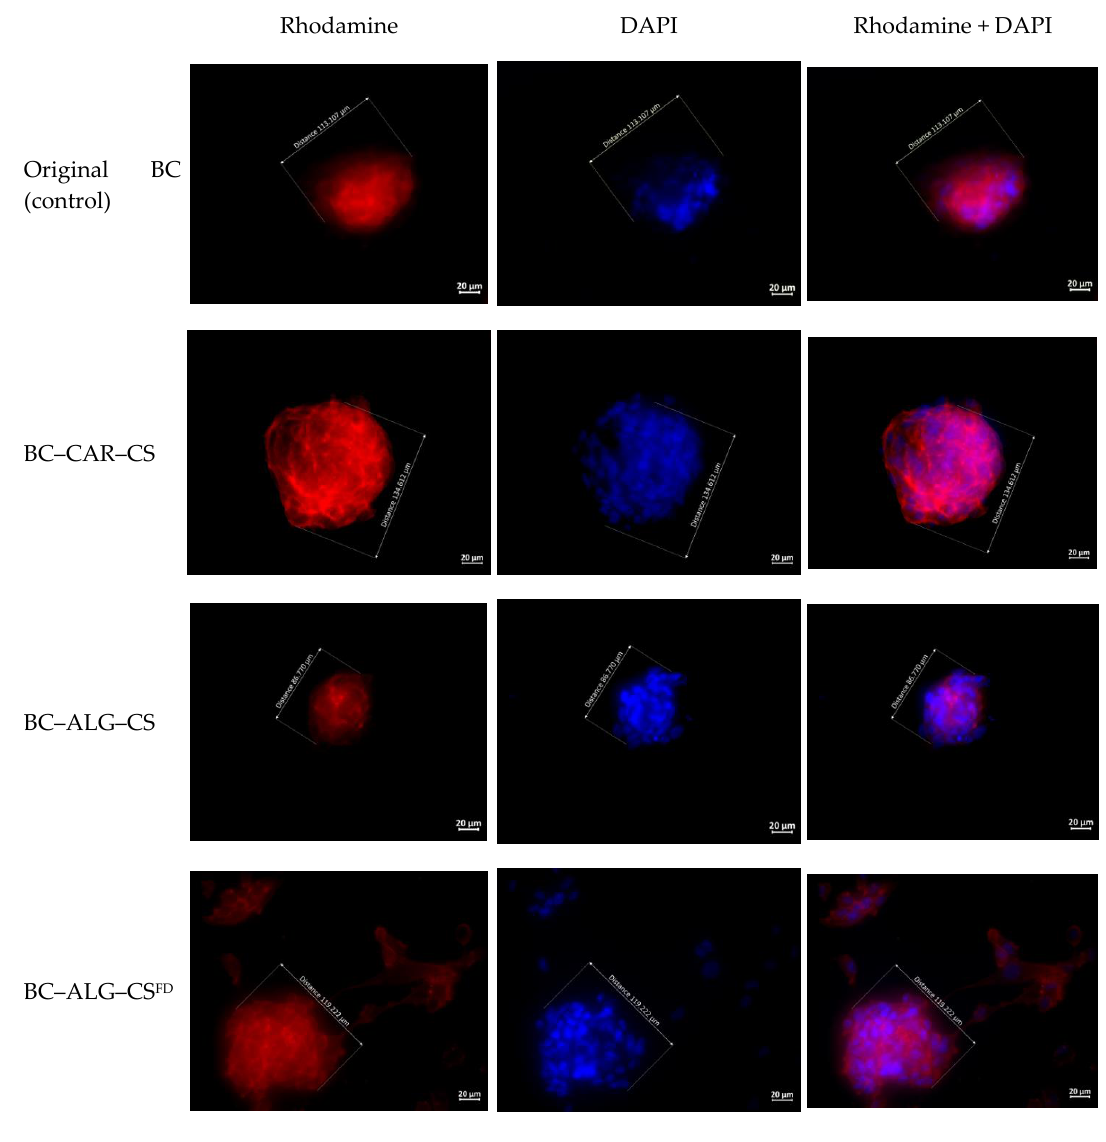
Figure 5. Multipotent mesenchymal stem cells adhered to the surfaces of glass and scaffolds. The fibrillar actin of the cytoskeleton was stained with rhodamine fluorochrome; nuclei were stained with DAPI. Combined two-channel image, magnification ×40.